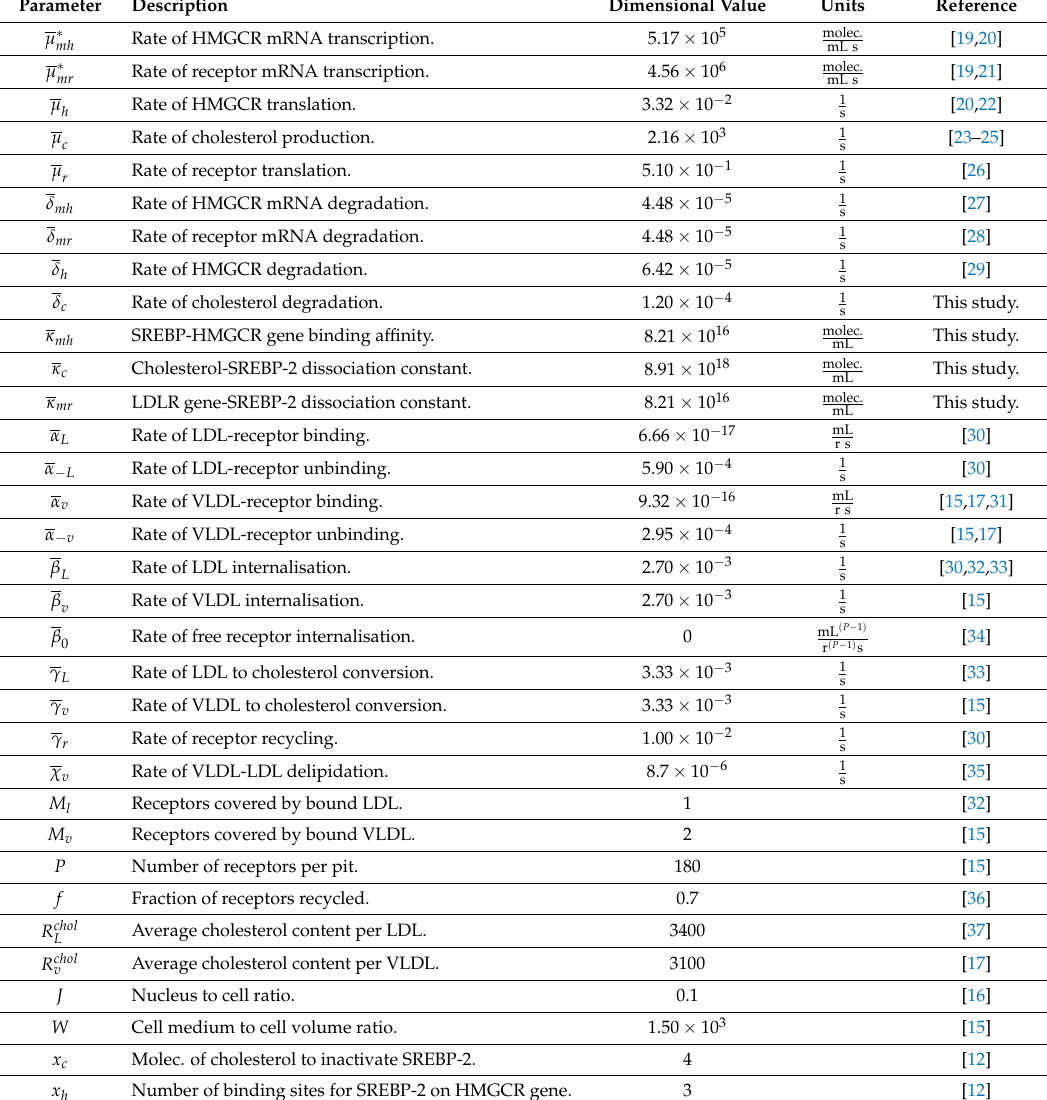
Table 1. Dimensional model parameters. Molec. denotes molecules, r receptors and conc. concentration.